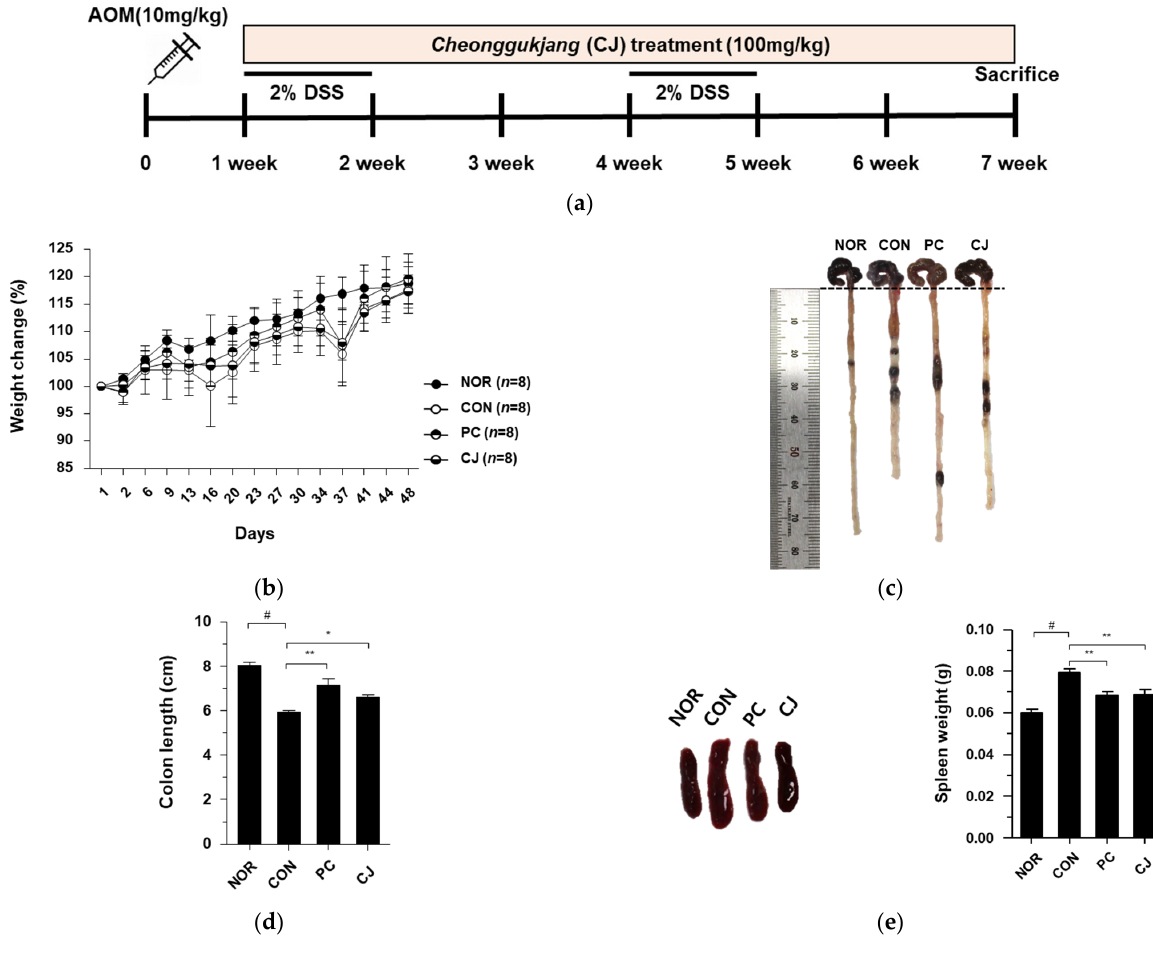
Figure 1. Effects of CJ on pathological symptoms of AOM/DSS-induced colorectal cancer (CAC) mice. ( a ) Experimental design; ( b ) weight change (%); ( c ) representative pictures of colon in mice; ( d ) colon length in mice; ( e ) representative pictures of spleen and spleen weight in mice. Values are means ± standard deviation ( n = 8); NOR, normal group; CON, control group; PC, positive control group; CJ, cheonggukjang treated group; #, p < 0.05 versus normal group; **, p < 0.005; *, p < 0.05 versus control group.